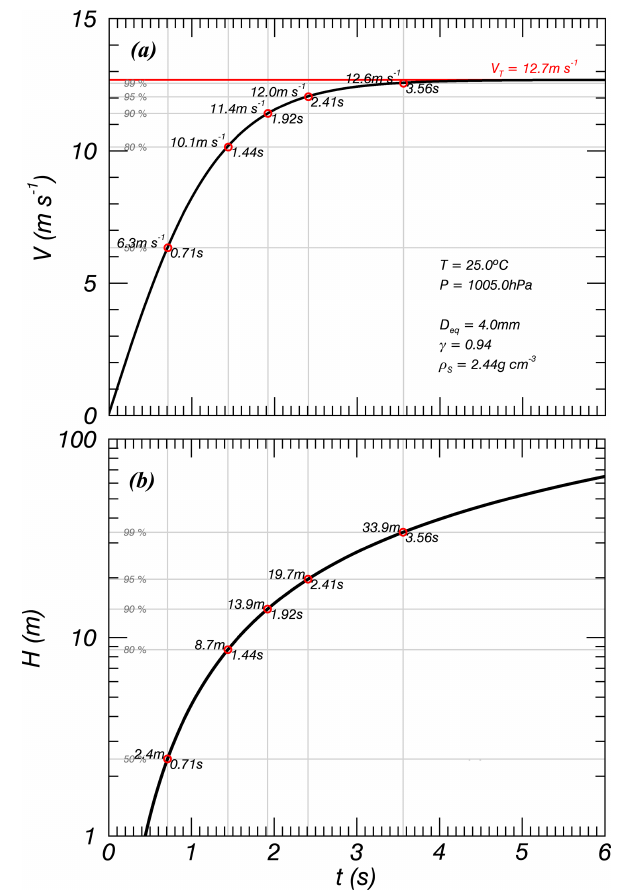
Figure A1. Theoretical (a) fall velocity and (b) falling height for a spheroid with D = 4mm, considering the surface roughness coeffi- cient of the volcanic ash particle (1.07 − 1 ) relative to its fall velocity (Bagheri and Bonadonna,